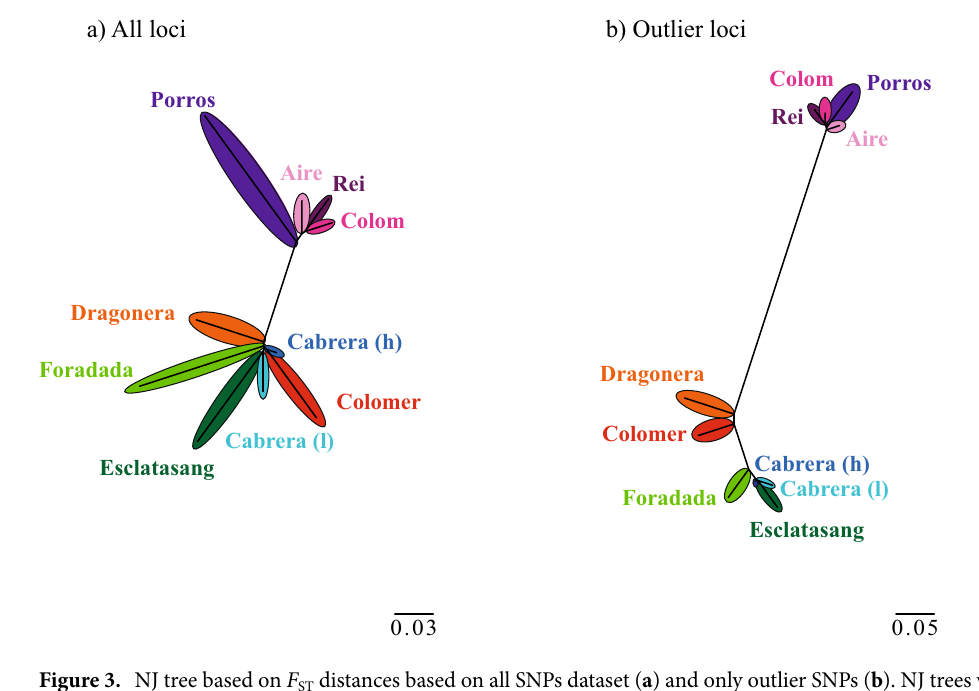
Figure 3. NJ tree based on F ST distances based on all SNPs dataset ( a ) and only outlier SNPs ( b ). NJ trees were inferred using Mega 7 60 and modified with Adobe Illustrator 2020.